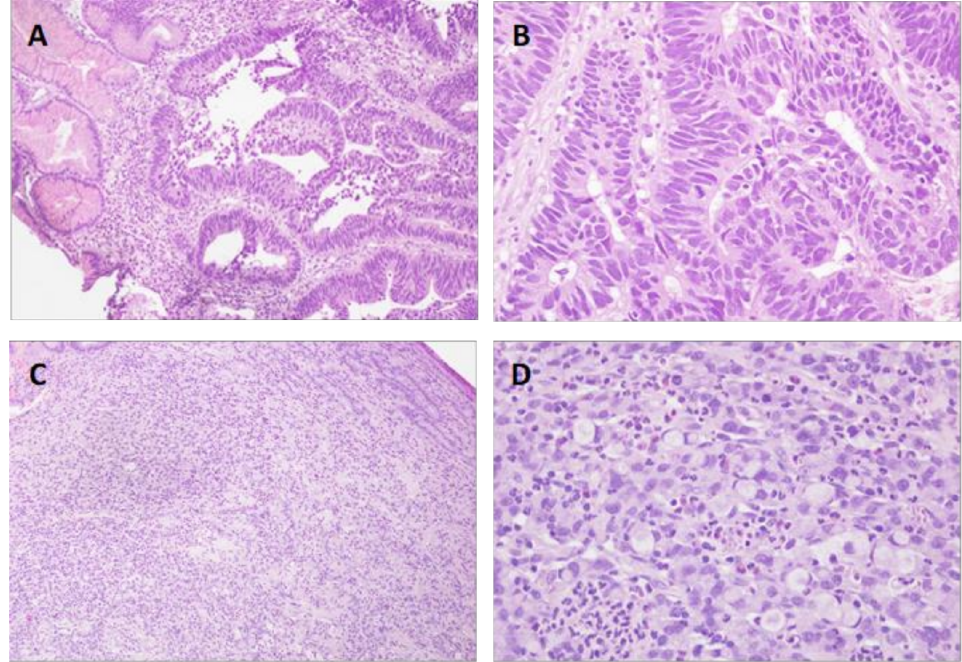
Figure 1. Histological types of gastric cancer according to the Lauren classification. ( A , B ): Intestinal type. Normal gastric mucosa and tumor nests with intestinal adenocarcinoma morphology are observed (( A ), 100 × ; ( B ), 400 × ). ( C , D ): Diffuse type. There is diffuse infiltration of tumor cells, some with signet ring cell appearance (( C ), 100 × ; ( D ), 400 × ).